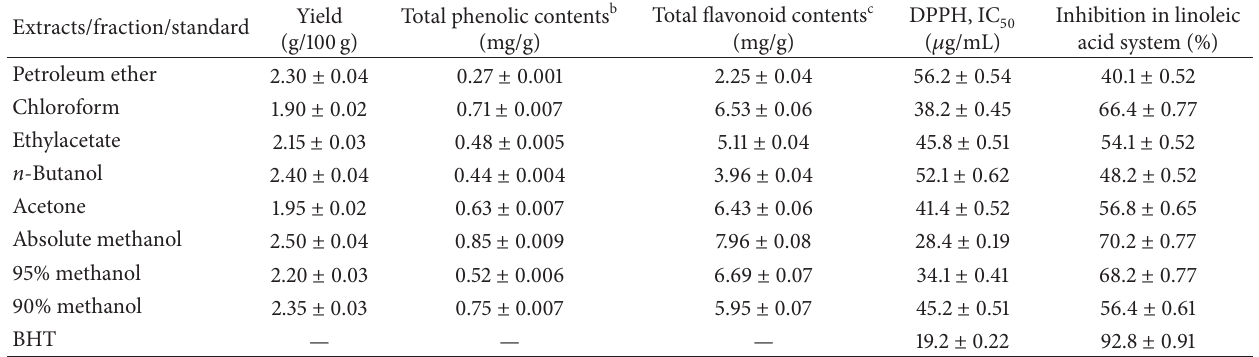
Table 1: Antioxidant activity of C. viminalis leaves a .